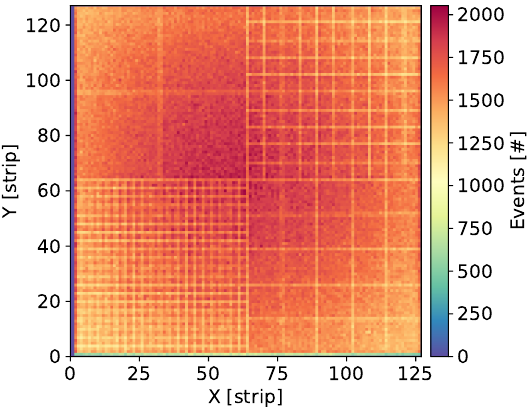
Figure 15. GEM detector D . Map of cumulative counts of reconstructed events for detector bias voltage of